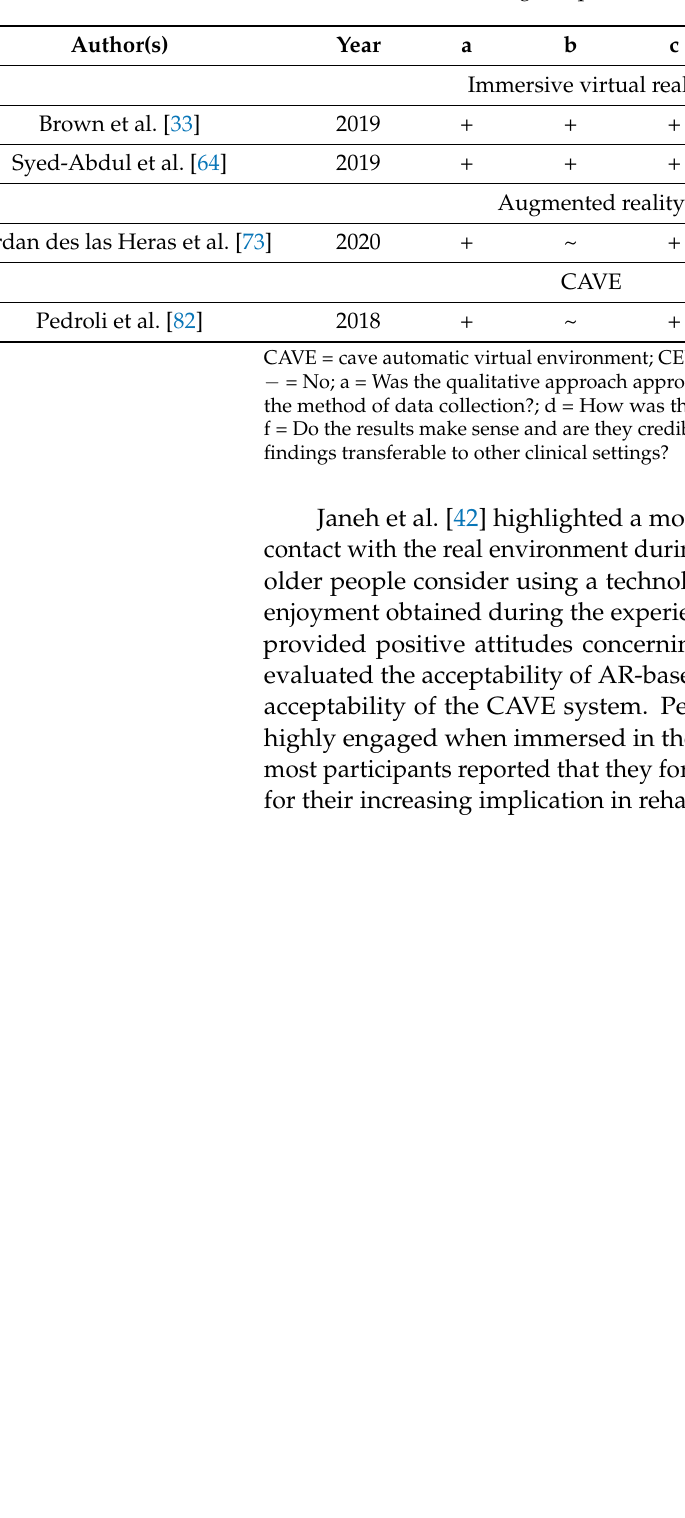
Table 4. CEBM scale rating for qualitative